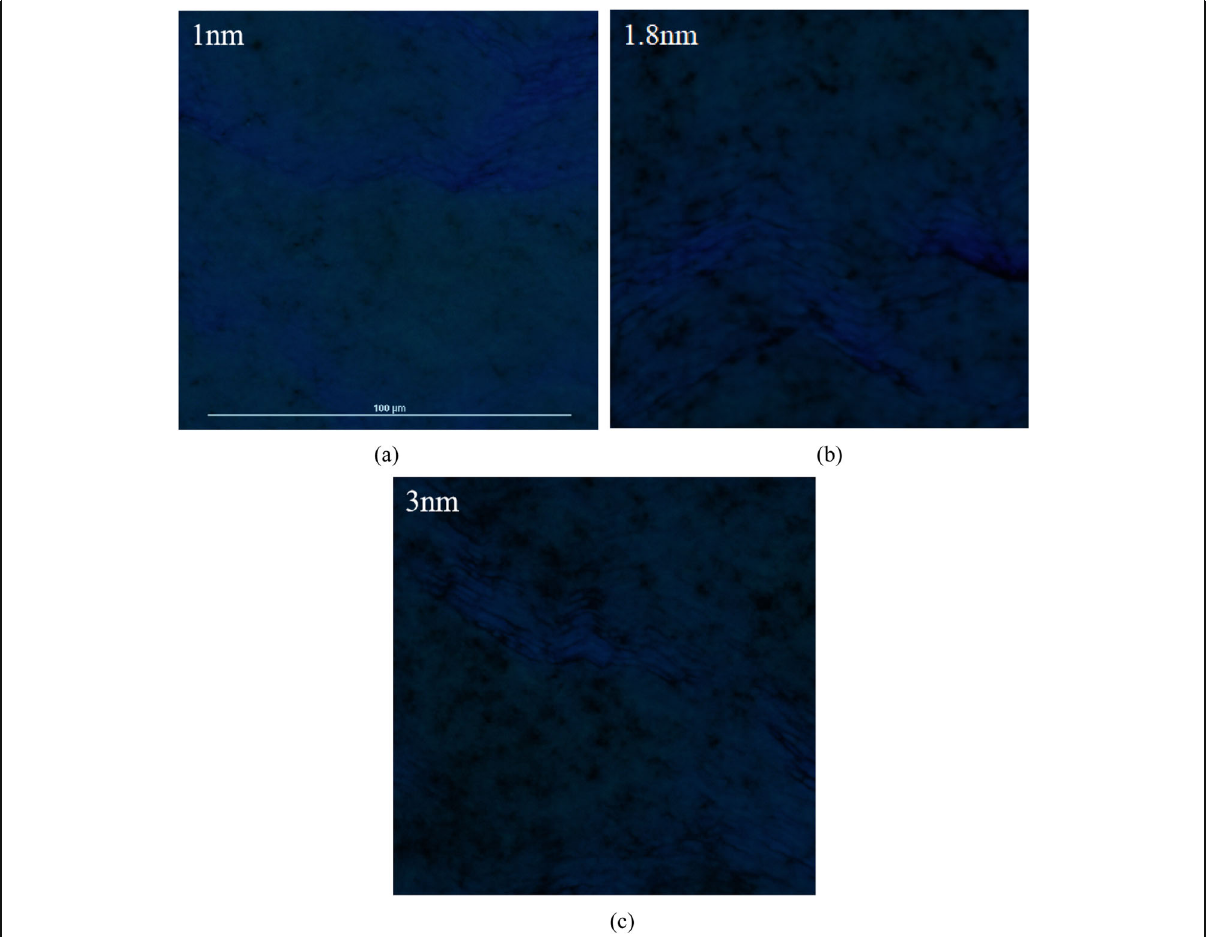
Fig. 7 Micro-PL images of samples A, B, and C with various LT-GaN cap layer thickness ( a ) 1 nm, ( b ) 1.8 nm, and ( c ) 3.0